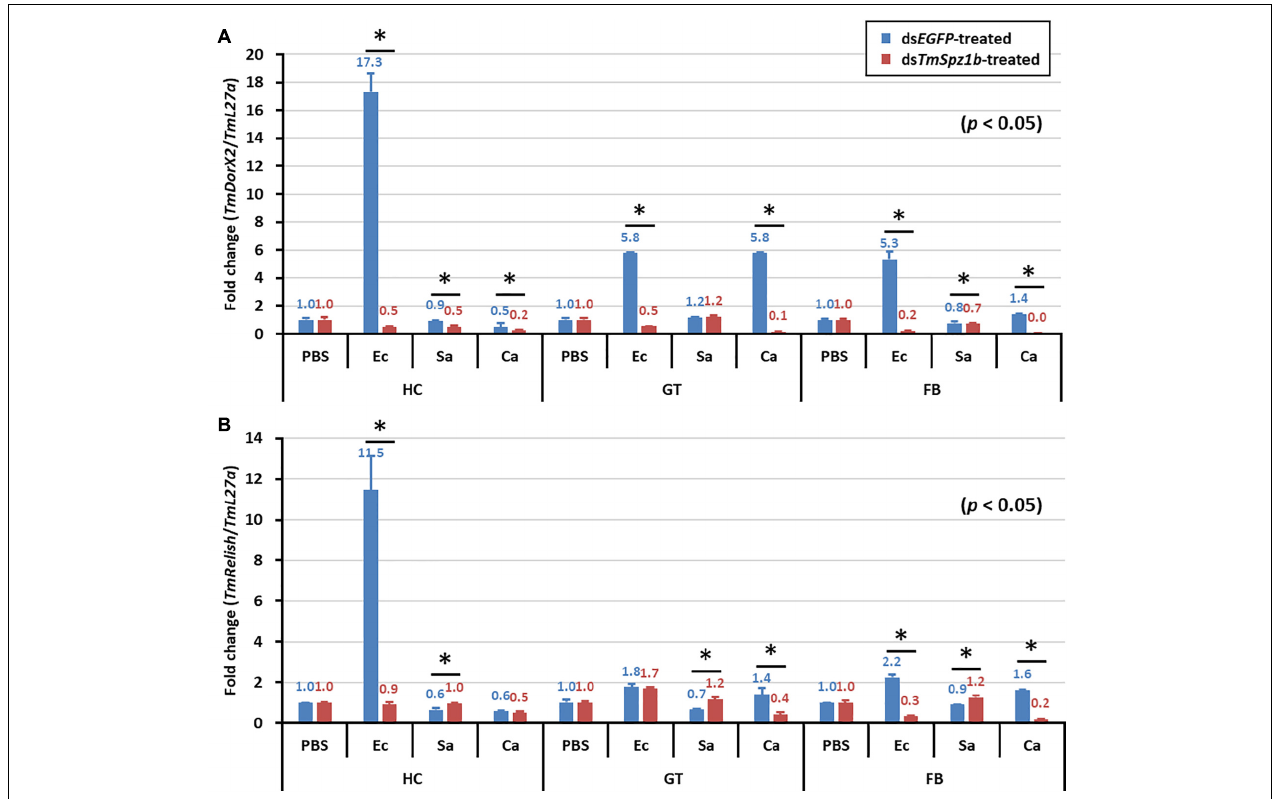
FIGURE 9 | Effect of TmSpz-1b silencing on the transcriptional regulation of NF- κ B genes after injections of E. coli, S. aureus , and C. albicans. mRNA expression levels of the NF- κ B genes viz. TmDorX2 (A) , and TmRelish (B) have been investigated by RT-qPCR. Larvae were injected with ds EGFP as a negative control, and TmL27a expression was assessed as an internal control. All experiments were performed in triplicate. Asterisks indicate significant differences in NF- κ B gene expression between the ds TmSpz-like- and dsEGFP- treated groups when compared by Student’s t -test ( P <